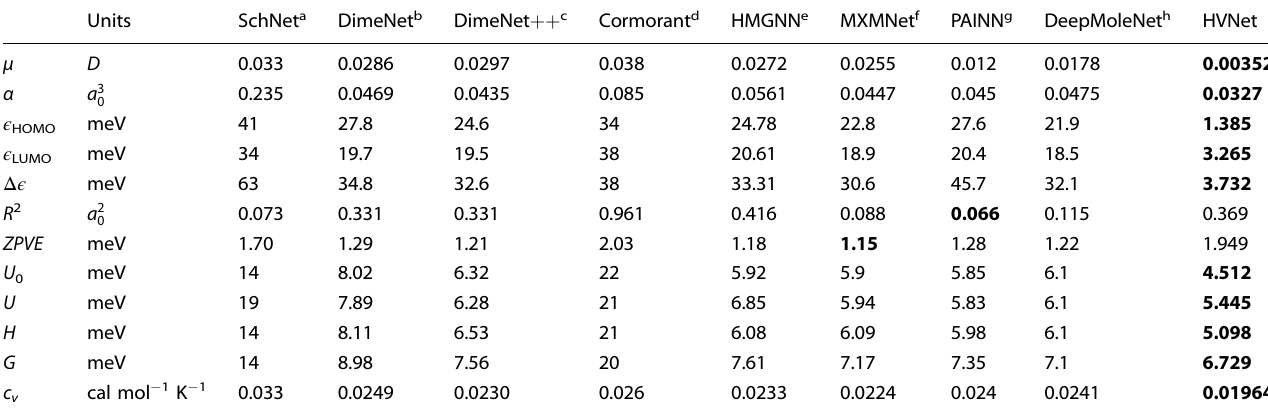
Table 2. Comparison of the MAEs between several benchmark models and HVNet trained on QM9 dataset.